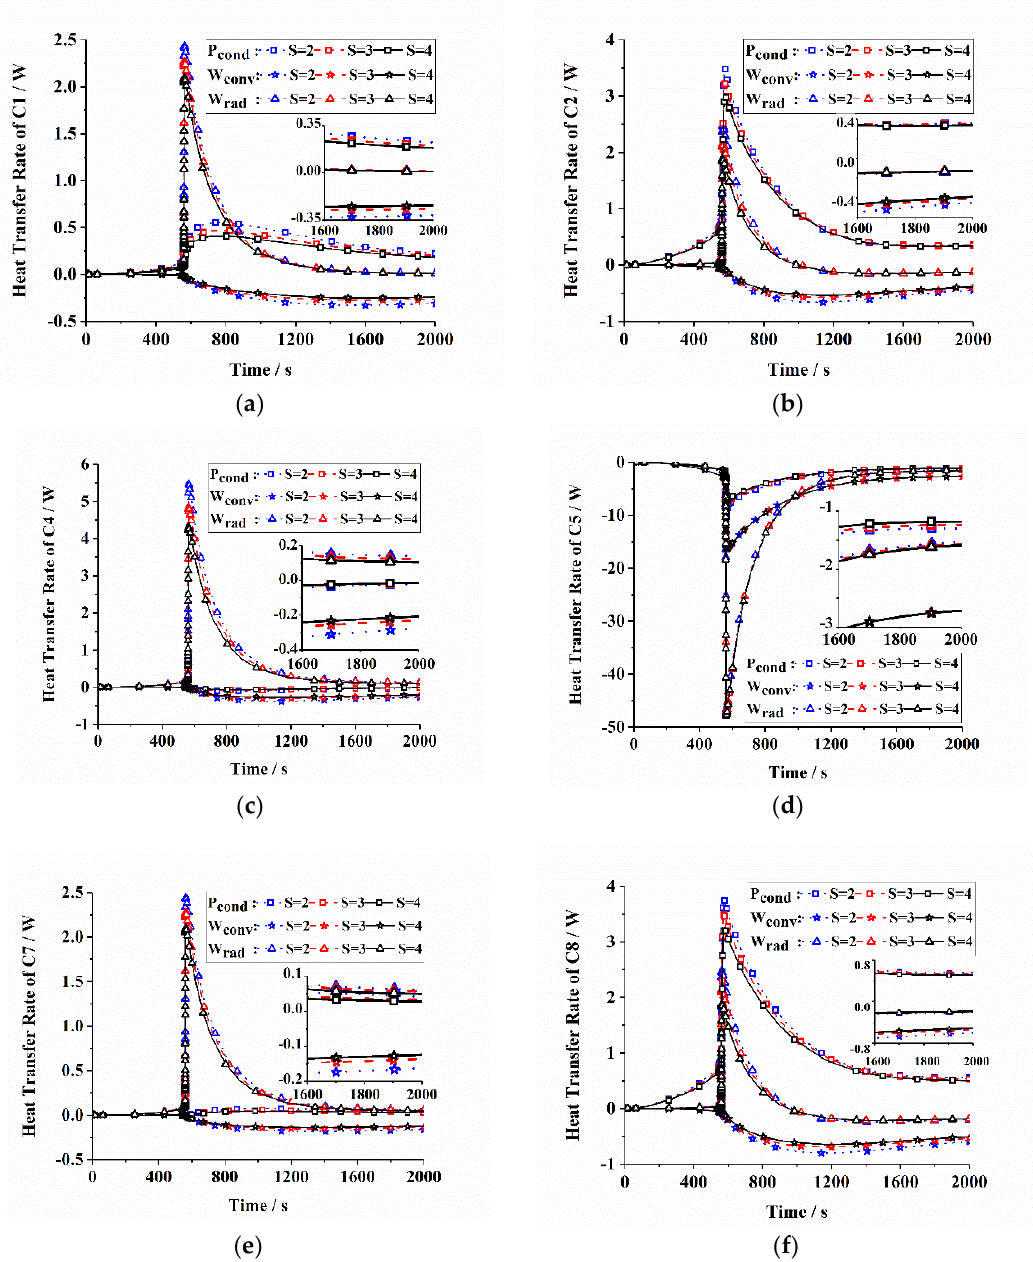
Figure 3. Heat transfer rates of different heat transfer modes of each cell when S = 2, 3 and 4 mm (R s = 5 mm, W = 10 mm); ( a ) C1, ( b ) C2, ( c ) C4, ( d ) C5, ( e ) C7, ( f ) C8.